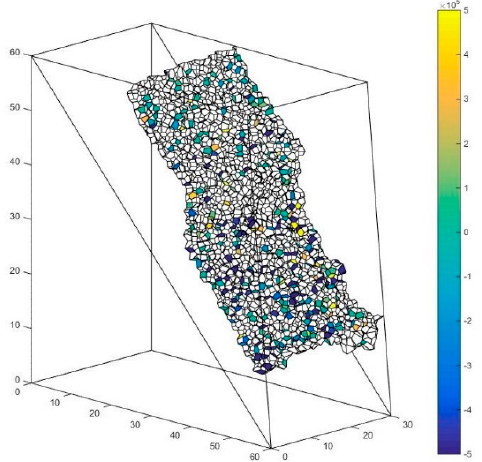
Figure 21. The contact force of the particle contact along the z-direction.